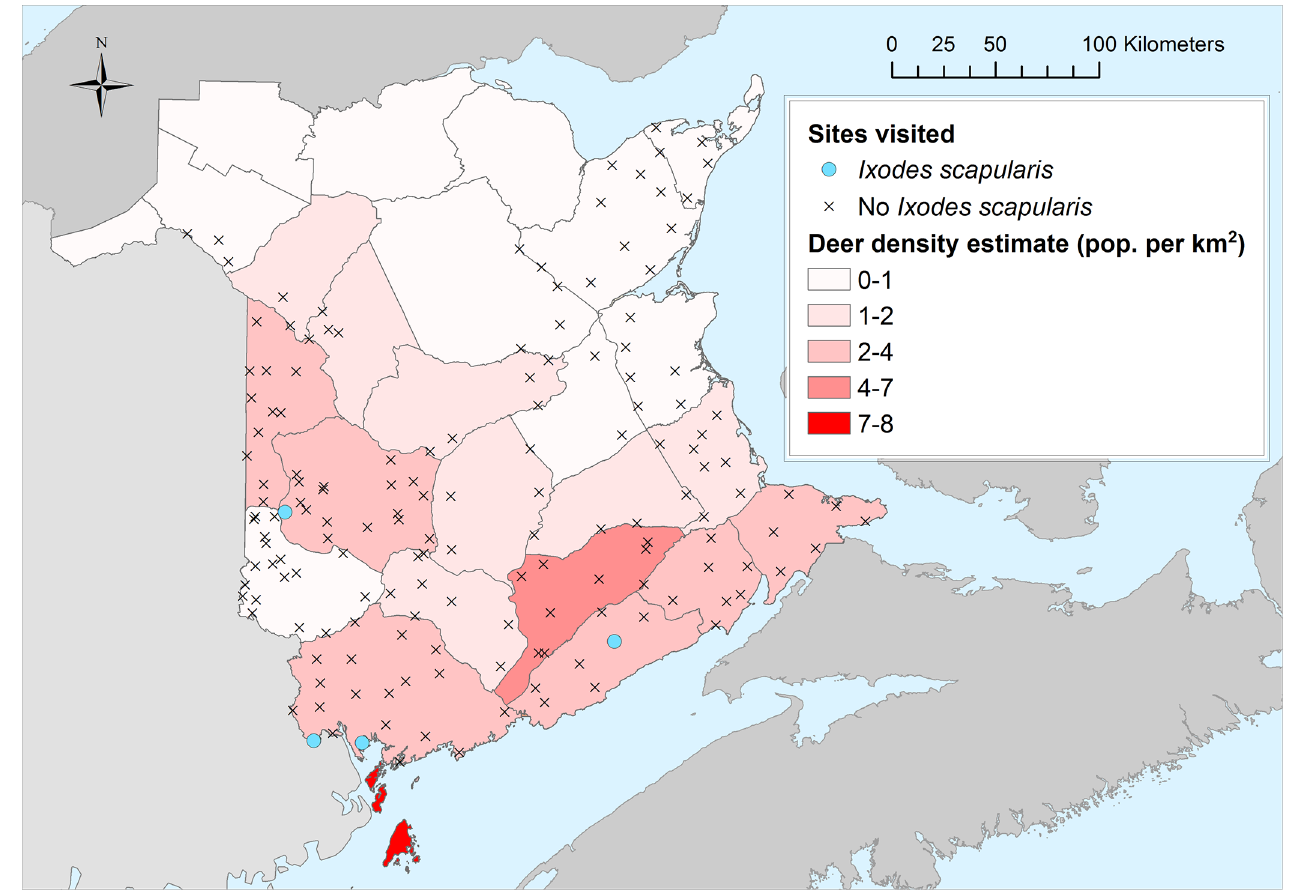
Fig 4. White-tailed deer densities. Estimated densities of white-tailed deer/km 2 are shown for each wildlife management zone in New Brunswick for 2014. The map was created in ArcGIS Version 10.2 (ESRI. Redlands,